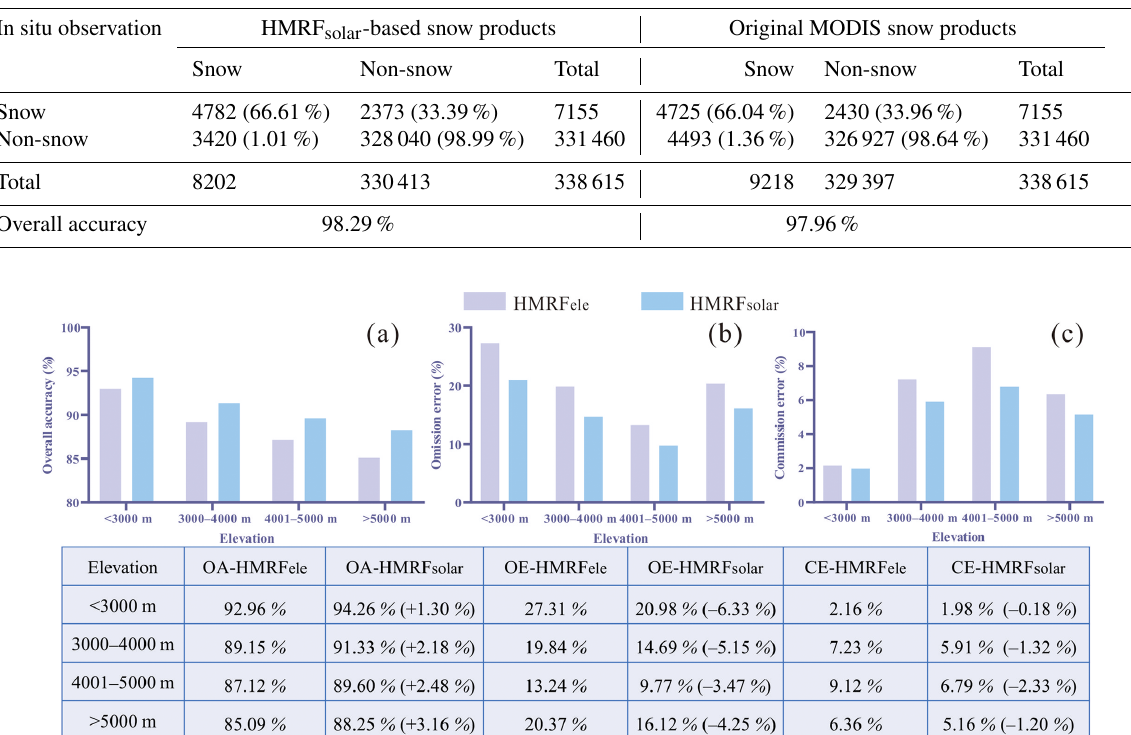
Table 2. Confusion matrices between HMRF solar -based, original MODIS snow products and in situ observation for gap-free pixels in original MODIS snow products during 2002–2021.